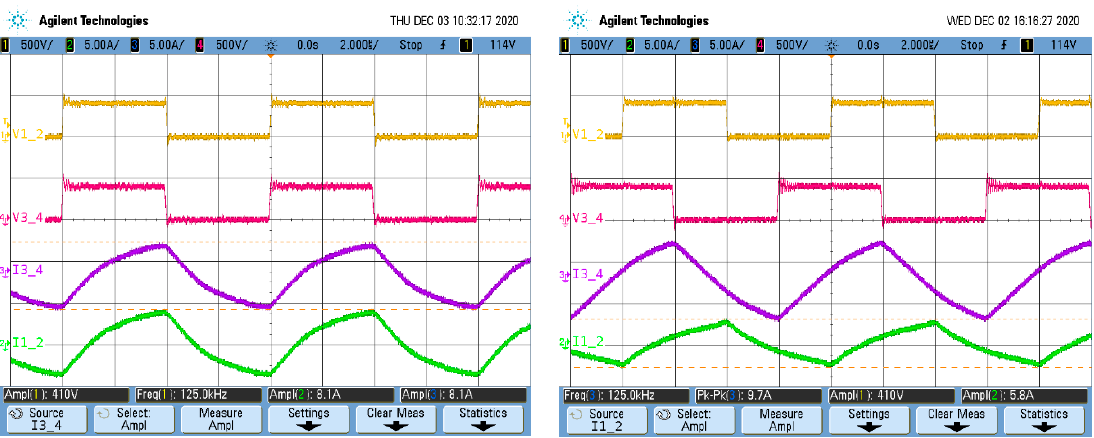
Figure 15. From top to bottom: Midpoint voltages of phases 1 and 2, v 1,2 . Midpoint voltages of phases 3 and 4, v 3,4 . Resonant current of phases 1 and 2, i 1,2 . Resonant current of phases 3 and 4, i 3,4 . Left: Full load condition ( Ψ 0 = Ψ 1 = Ψ 2 = Ψ 3 = 0°). Right: 70% of full load condition ( Ψ 0 = Ψ 1 = 0°, Ψ 2 = Ψ 3 = 90°).